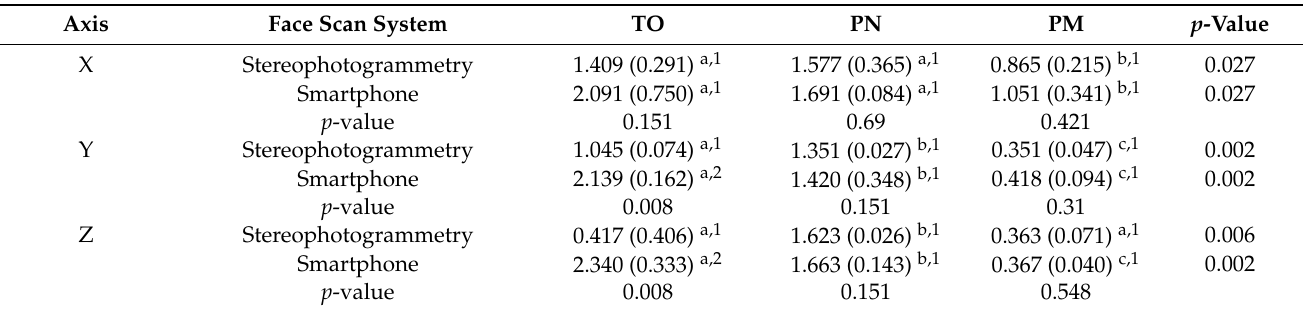
Table 1. Mean (standard deviation) of linear deviations in the image registration of intraoral scan to facial scan in the X, Y, and Z axes.